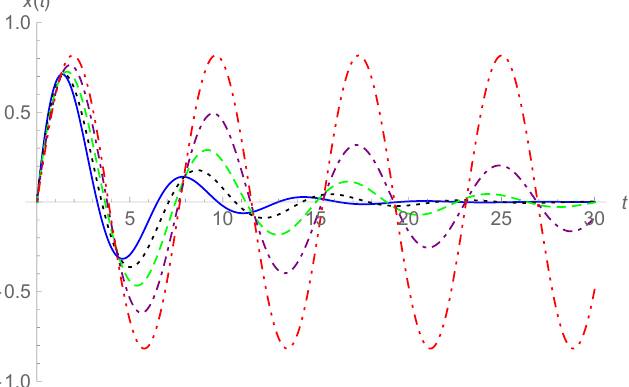
Figure 6. Curves of x ( t ) for m = k = 1, c = 0.5, and for α = 1 (solid line), 1.25 (dotted line), 1.5 (dashed line), 1.75 (dotted-dashed line), and 2 (dotted-dotted-dashed line).